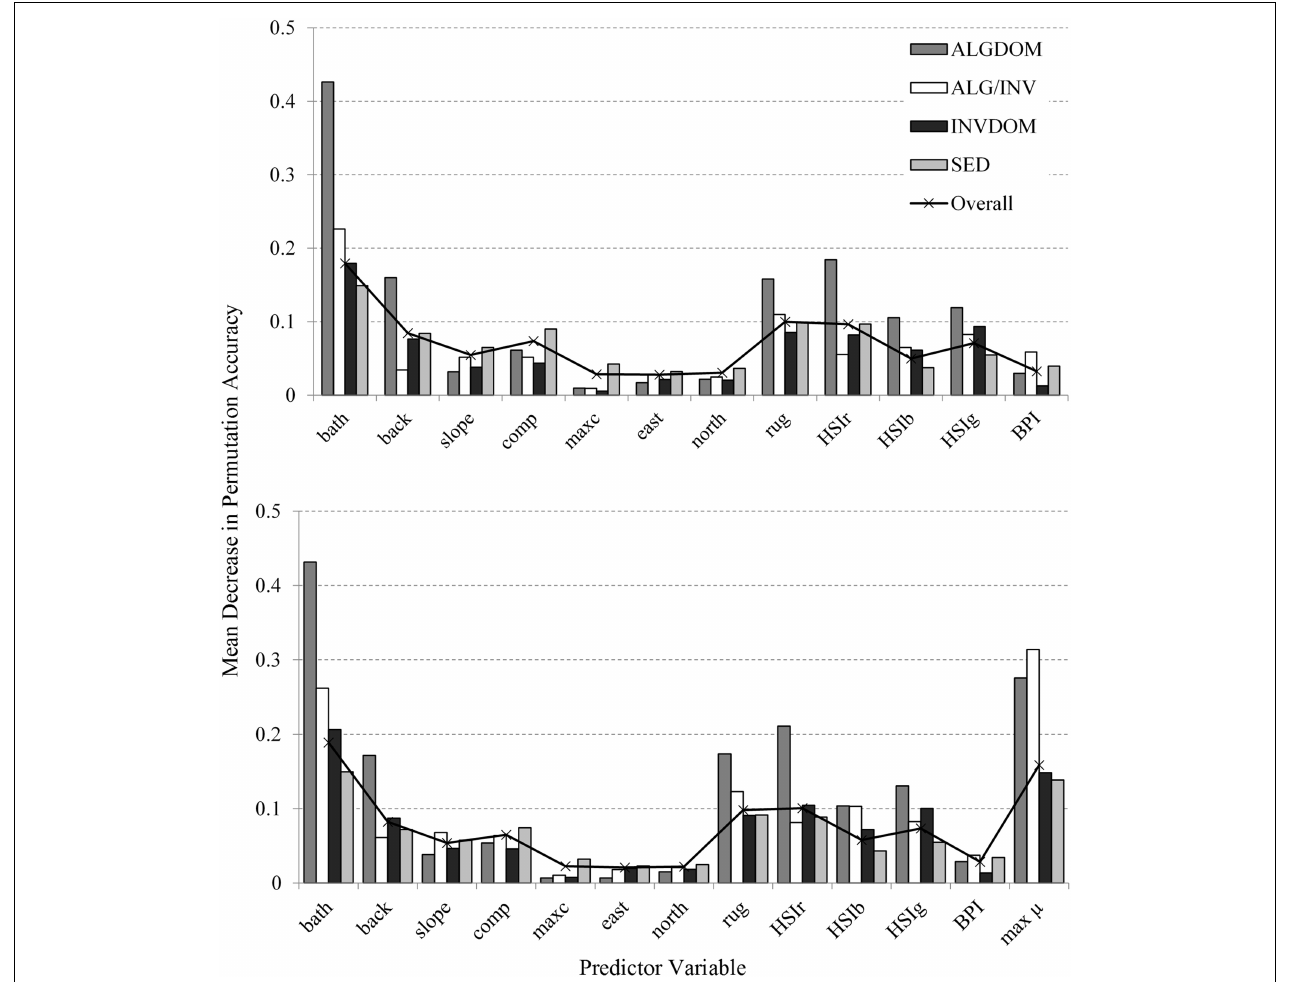
FIGURE 6 | Variable importance assessed by mean decrease in permutation accuracy obtained from the Random Forests classification (y-axis). Mean decrease in permutation accuracy is calculated using the difference between the misclassification rate of the out of bag (OOB) data, and the misclassification rate if values of a given variable are randomly